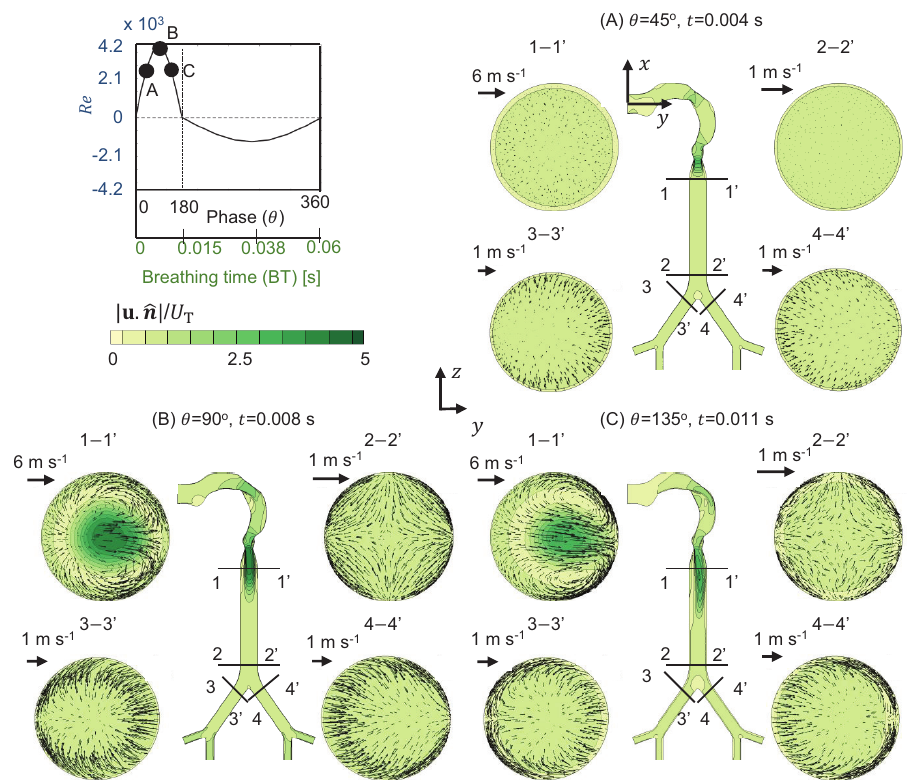
Figure 4. Contours of magnitude of plane-normal velocity component (non-dimensionalized with mean flow speed in trachea, U T ) with superimposed in-plane velocity vectors for Planes 1–4 at various time-points during inhalation for Wo = 24.1 at IT/BT = 25%. A is at Phase θ = 45 ◦ (=25% IT), B is at Phase θ = 90 ◦ (=50% IT) and C is at Phase θ = 135 ◦ (=75% IT). At IT/BT = 25%, for both Wo = 2.41 and Wo = 24.1 conditions, strong axial